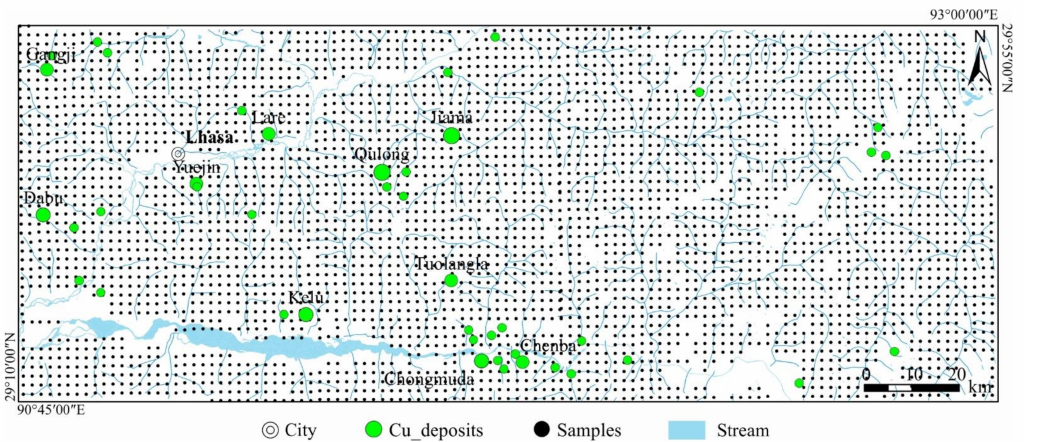
Figure 3. Geochemical sample